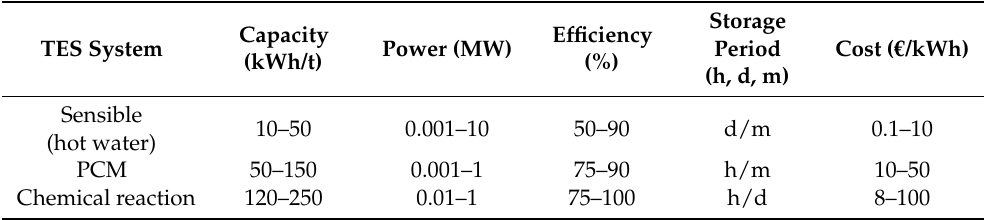
Table 2. Typical parameters of TES systems (Adapted, Copyright 2011 IEA,